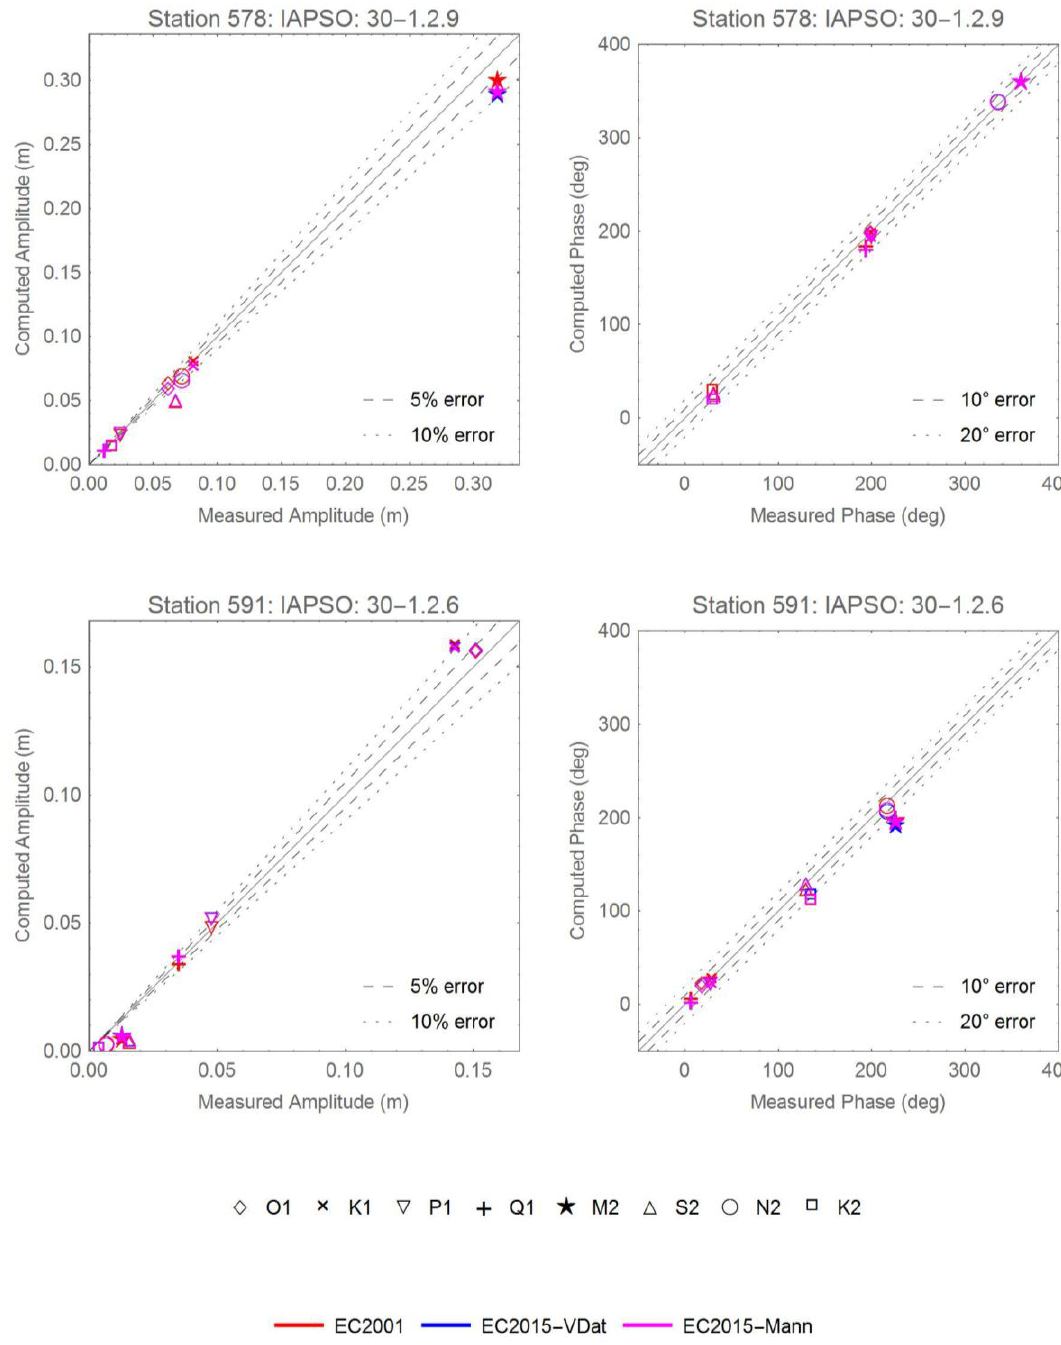
Figure B5. Scatterplots of computed versus measured harmonic data for representative deep IHO stations.